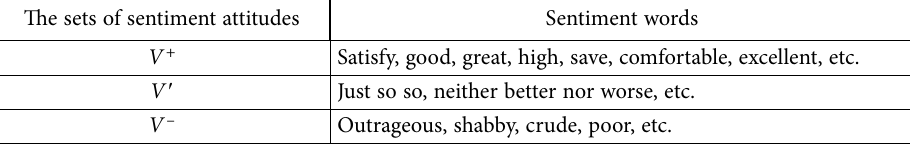
Table 2. The sentiment words and their attitudes The sets of sentiment